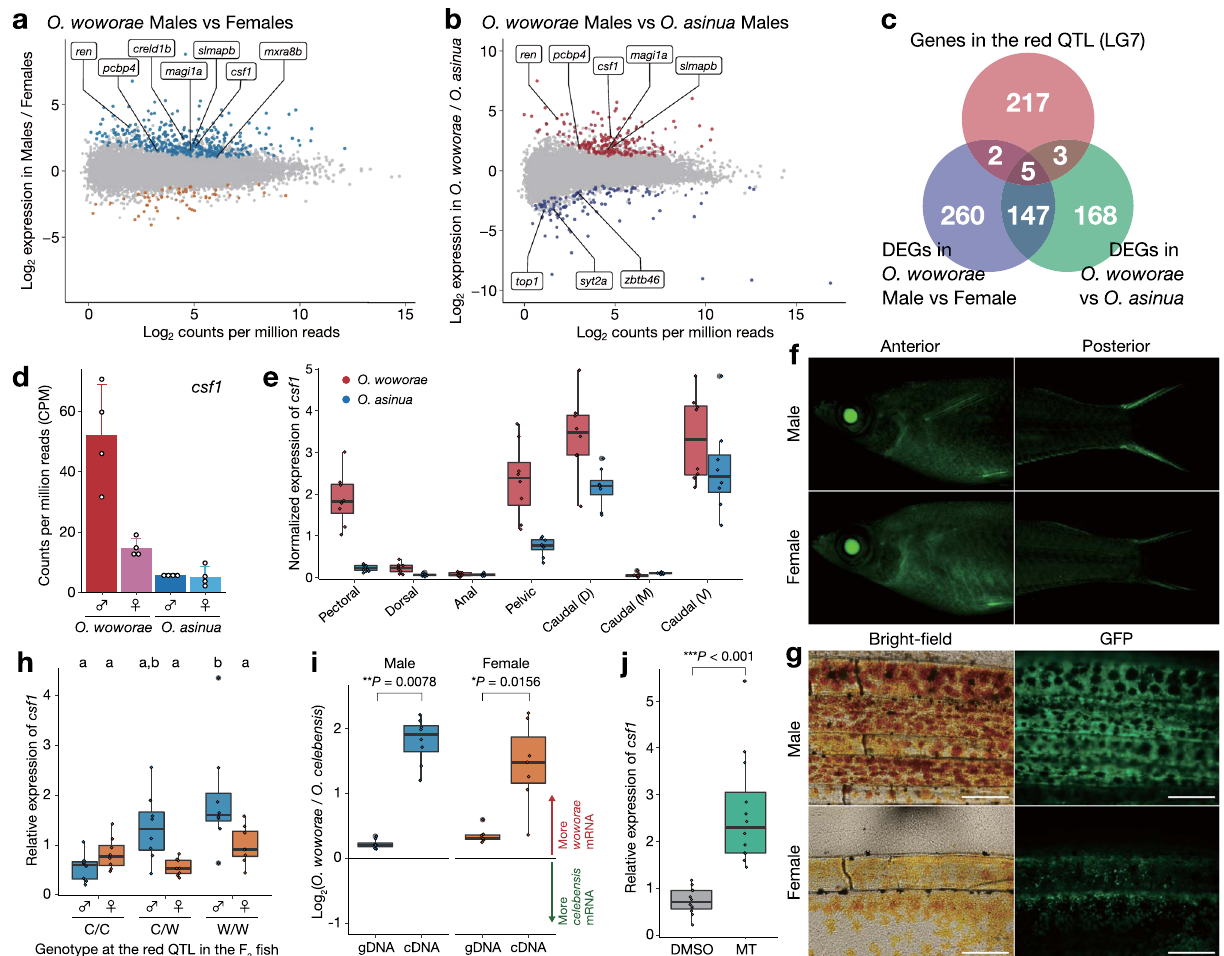
Fig. 3 Increased expression of csf1 in male pectoral fi ns by cis -regulatory mutations. a , b RNA-seq of the pectoral fi ns. Minus-Average (MA) plots with the average gene expression levels on the X axis and log 2 fold-change in expression between the sexes in O. woworae ( a ) or between O . woworae males and O. asinua males ( b ) on the Y axis. Each dot represents a single gene with differentially expressed genes (DEGs) colored (FDR < 0.01). The gene names of DEGs within the red pectoral fi n QTLs are also shown. c Venn diagram indicating overlap among inter-sex DEGs in O. woworae , interspecies DEGs in males, and genes within 95% Bayesian credible intervals of all red pectoral fi n QTLs on LG7. Five genes were identi fi ed as strong candidate genes. d Comparison of csf1 expression levels among males and females of O. woworae and O. asinua , showing the highest expression in O. woworae males ( n = 4 for each). Mean± SD are shown. A dot indicates each individual. Expression levels of the other four candidates are shown in Supplementary Fig. 4. e qPCR analysis comparing the relative expression levels of csf1 in the seven different fi n parts of O. woworae (red) and O. asinua (blue) males ( n = 8 for each). The expression levels were normalized by the expression of an internal control gene, rpl13a . f GFP fl uorescence in the pectoral (left) and caudal fi ns (right) in males (upper) and females (lower) of GFP knock-in O. woworae ( csf1 Olhs:GFP ). Expression in the lens is caused by the basal activity of the heat-shock promoter. g Microscopic images of pectoral fi ns in bright- fi eld (left) and GFP fl uorescent observation (right). Images are representative of three experiments. Scale bars indicate 200 µ m. h Expression levels of csf1 in the pectoral fi n of the F 2 family ( n = 8 for each). The X axis indicates the genotype at the red pectoral fi n QTL on LG7 (C/C, homozygous for the O. celebensis allele; W/W, homozygous for the O. woworae allele; C/W, heterozygote). Different letters above the boxes indicate signi fi cantly different groups ( P < 0.05, post hoc test with the Tukey ’ s honest signi fi cant difference method; see Supplementary Table 4 for the statistical results). i Allele-speci fi c expression analysis of csf1 in pectoral fi ns of the heterozygous fi sh ( n = 8 for each). The ratio of the O. woworae allele to the O. celebensis allele was signi fi cantly higher in cDNA compared with that in genomic DNA. The P values are calculated separately for each sex using two-sided Wilcoxon ’ s signed rank test (male, V = 36, P = 0.007812; female, V = 28, P = 0.01562; * P < 0.05 and ** P < 0.01). h , i the blue and brown colors indicate males and females, respectively. j Administration of methyltestosterone (MT) to O. woworae females increased csf1 expression in the pectoral fi n compared with the control fi sh administered dimethyl sulfoxide (DMSO) ( n = 12 in each group). The P value is calculated using two-sided Welch ’ s t test ( t 12.233 = − 5.4148, P = 0.00015, *** P < 0.001). The gray and green colors indicate fi sh with DMSO and fi sh with MT, respectively. e , h – j Each circle represents each individual, the center line indicates the median, box limits indicate the upper and lower quartiles, the whiskers indicate 1.5× interquartile range, and the points are outliers. Source data are provided as a Source Data fi